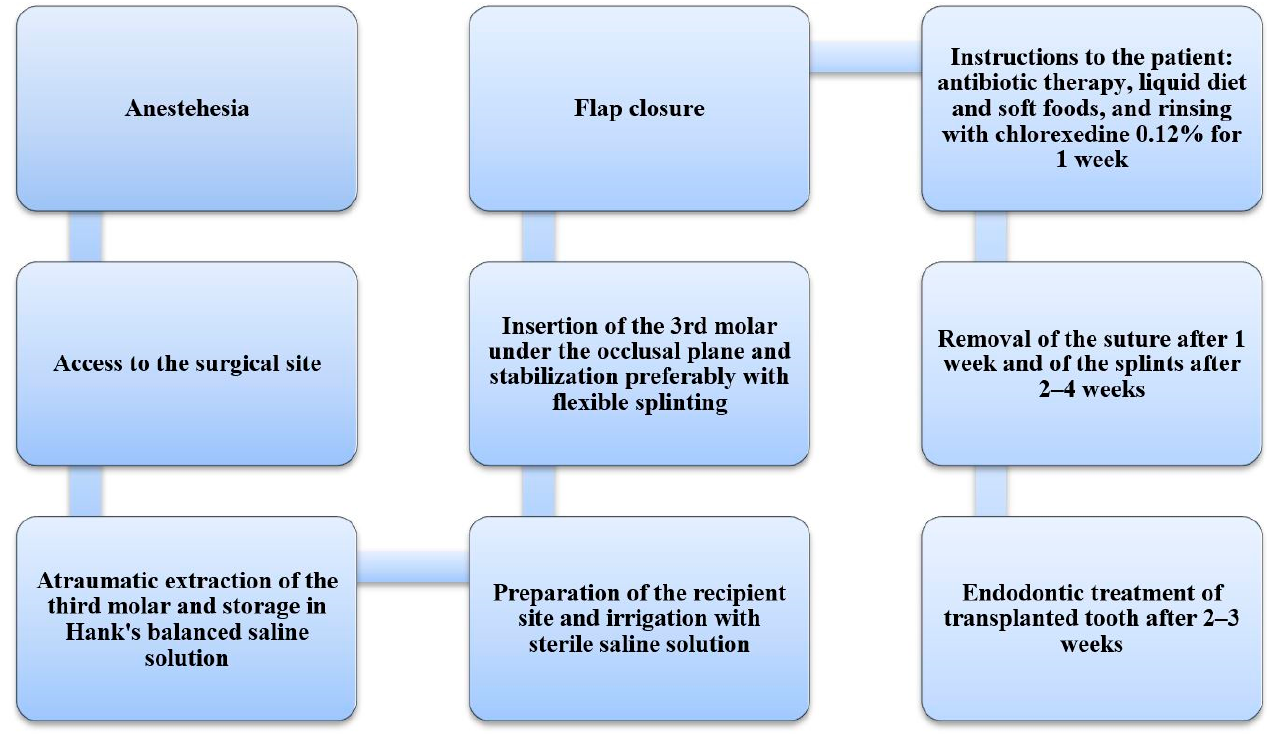
Figure 2. Flow chart of all surgical steps and procedures.